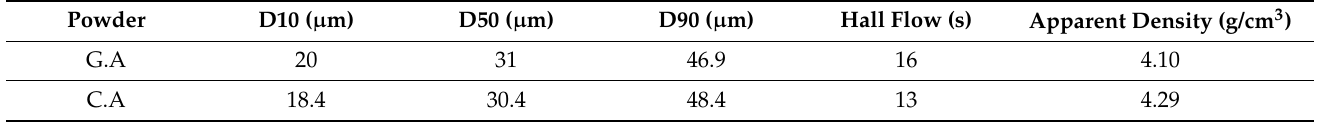
Figure 3. Particle-size distributions for both stainless steel powders obtained using laser diffraction and μ CT techniques. Table 4. Physical properties of the powders used in this study (manufacturer’s specifications).